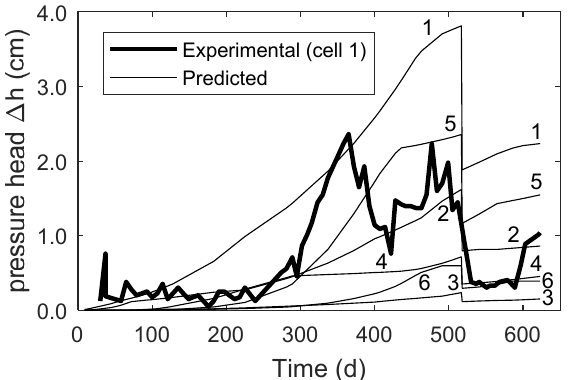
Figure 7. Pressure head buildup in cells 1 to 6 of column 1. The cell number is indicated next to each predicted line. The sudden reduction of pressure head at t = 517 d is caused by the reduction of influent flowrate from 6.9 ± 1.3 mL/min to 3.4 ± 0.5 mL/min.